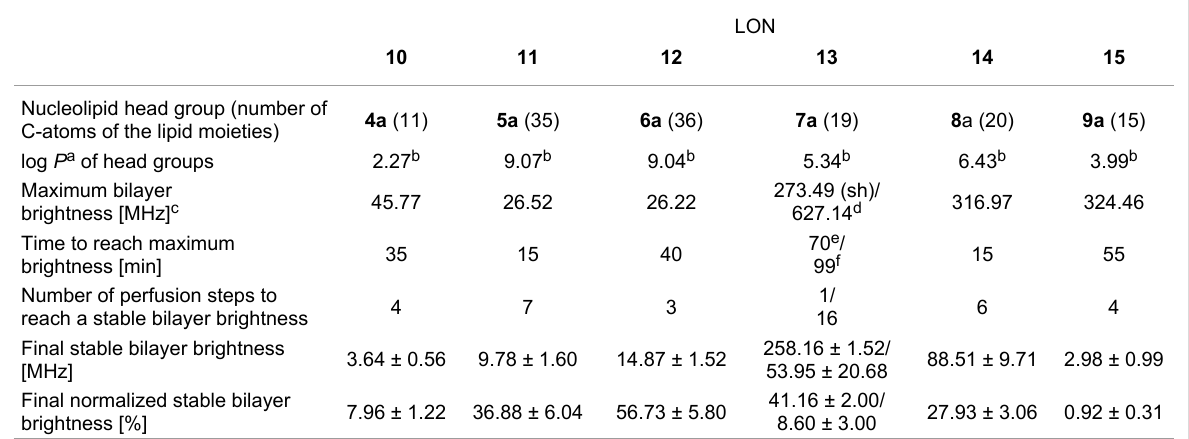
Table 2: Experimental results of the incorporation of the LONs into artificial lipid bilayers with respect to the log P values of the nucleolipid head groups.